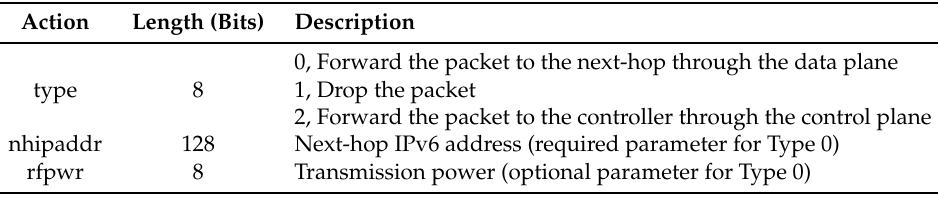
Table 2. Action field of the SD6WSN flow table entry.